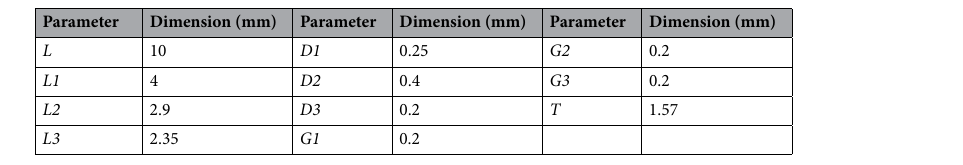
Table 1. Design parameters of proposed MTM unit cell.